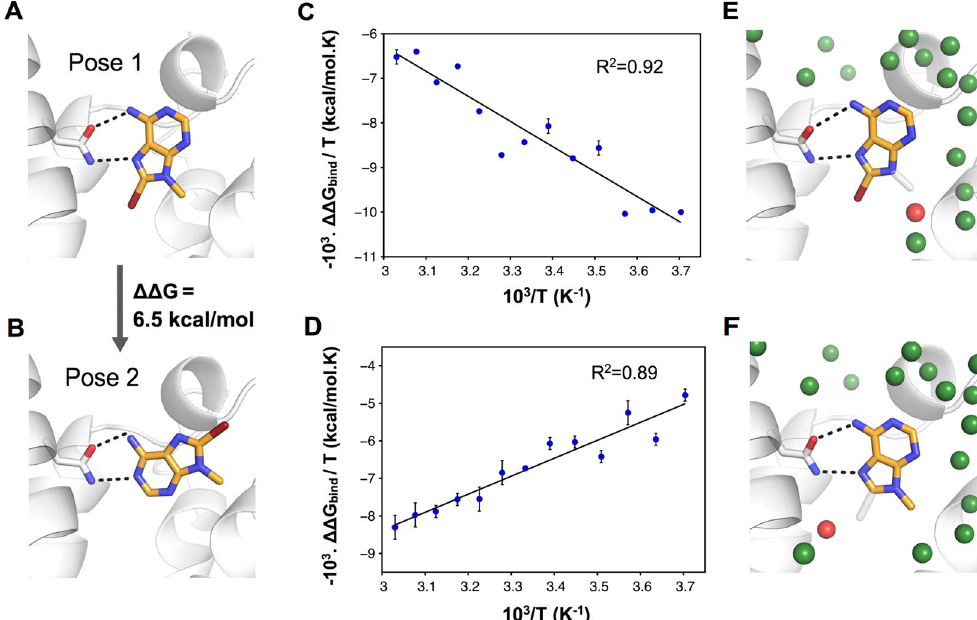
Figure 4. ( A ) Binding mode of compound 3 based on an A 2A AR crystal structure in complex with a related ligand (PDB code 4EIY). ( B ) Alternative binding mode for compound 3 . ( C,D ) Determination of entropy and enthalpy components of the relative binding free energy from MD/FEP calculations at different temperatures for compounds 3 and 4 ( C ), and compounds 2 and 3 ( D ). ( E,F ) Maps of binding site solvent structure from clustering of snapshots from a simulation of compound 4 ( E ) and 2 ( F ) in complex with the A 2A AR. The corresponding bromine and methyl substituents in compound 3 are represented as transparent grey sticks. In both cases, the water molecule displaced by compound 3 is shown as a red sphere. The orthosteric binding site of the